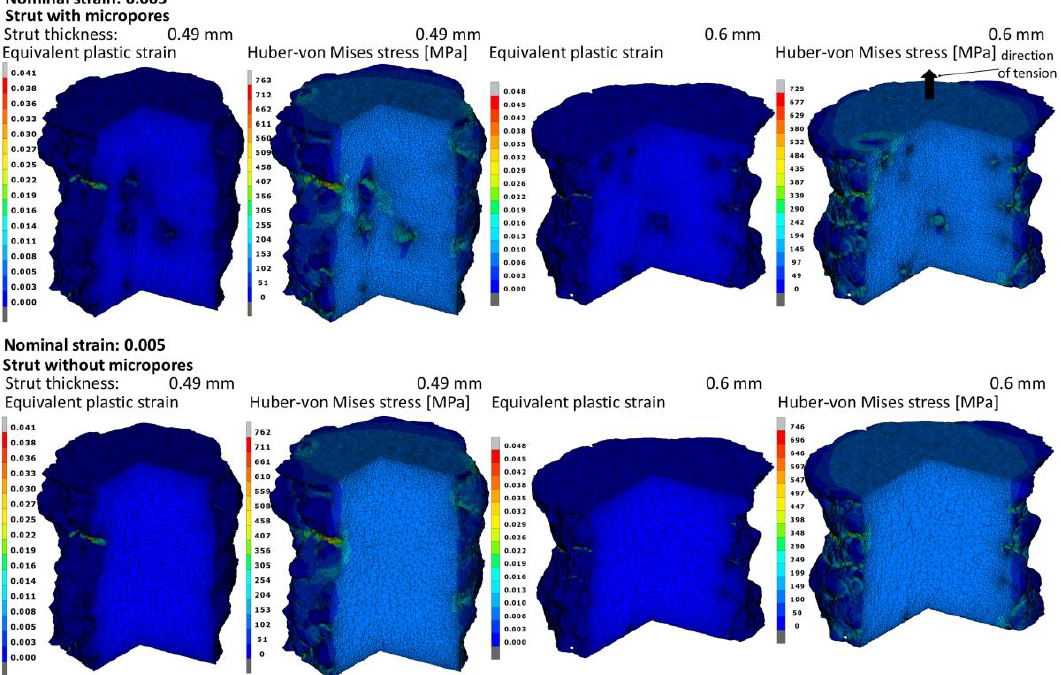
Figure 8. Equivalent plastic strain and Huber – von Mises stress fields in the struts with and without micropores at the moment of obtaining the nominal strain of 0.005.